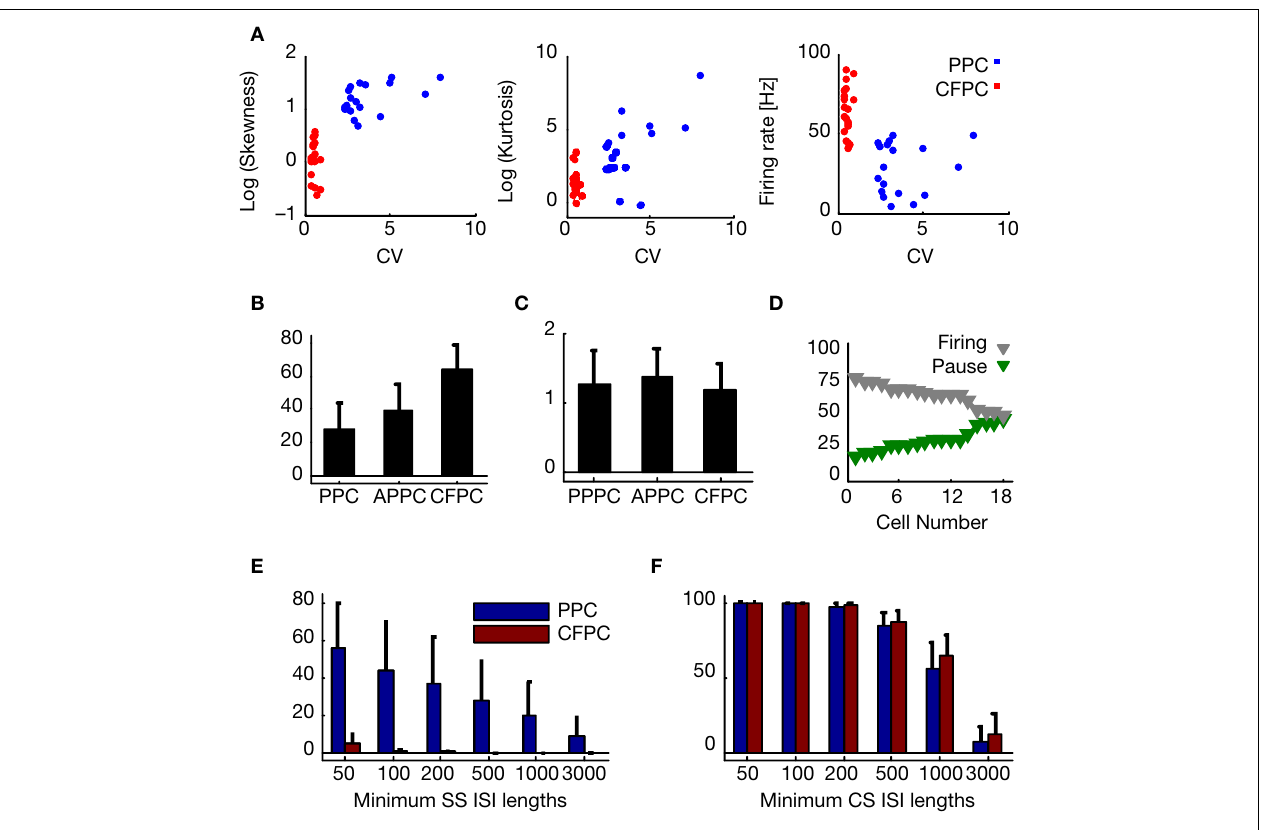
(green) and active state fi ring (gray) for all PPCs, sorted by increasing percentage of pause variance. (E) Fraction of time neurons spent in pauses plotted against various pause thresholds (PPCs: blue, CFPCs: red). Error bars represent std. (F) Analysis in (E ) applied to